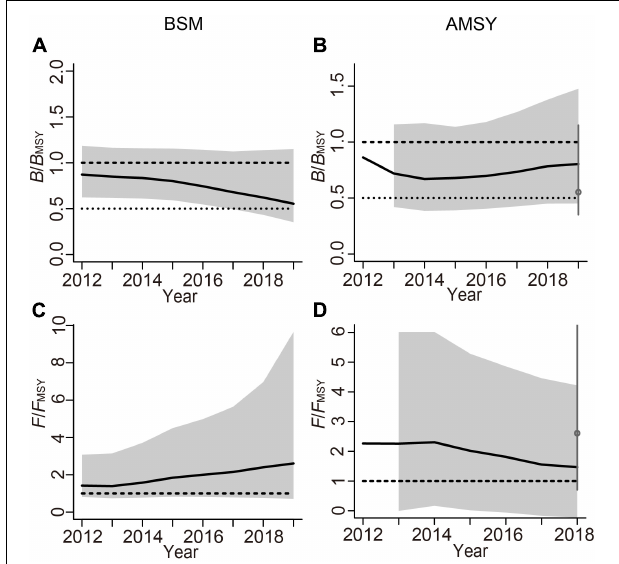
FIGURE 6 | Comparison of relative biomass (B/BMSY) and exploitation level (F/FMSY) trajectories estimated by BSM and AMSY methods, with the gray areas representing the 97.5% CIs. (A) Relative biomass (B/BMSY) trend estimated by BSM; (B) relative biomass (B/BMSY) trend estimated by AMSY; (C) relative exploitation level (F/FMSY) trajectory predicted by BSM; (D) relative exploitation level (F/FMSY) trajectory predicted by AMSY.